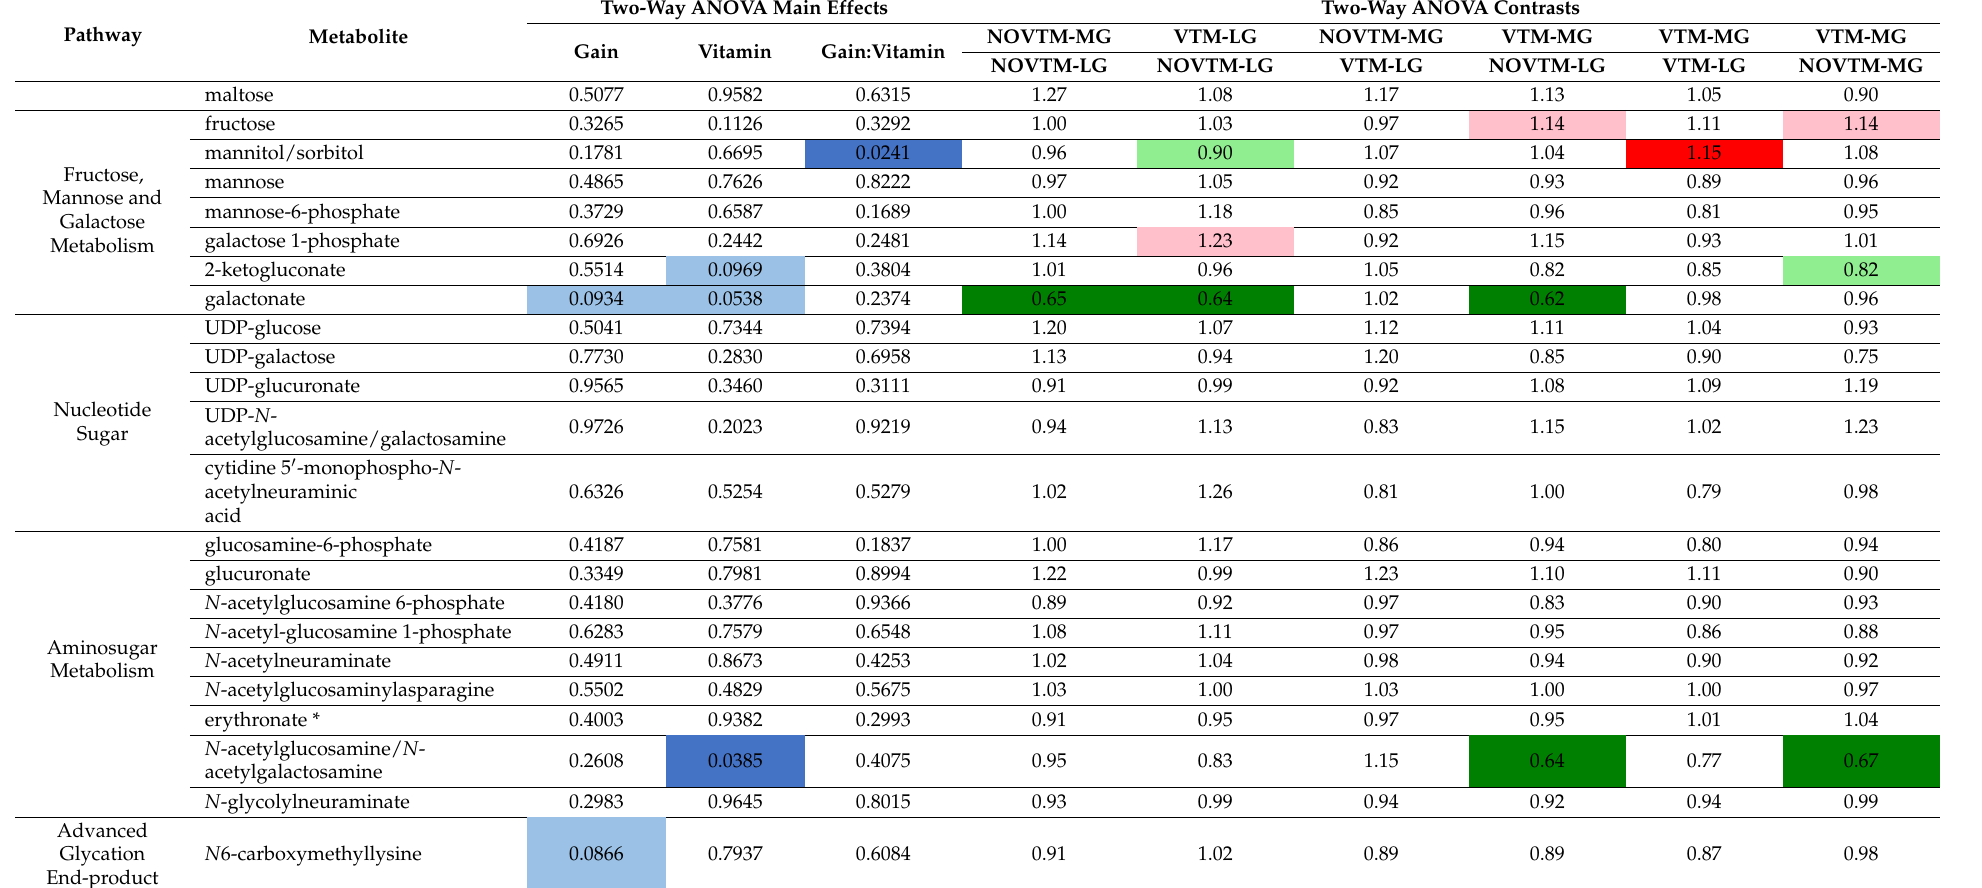
Red and green shaded cells indicate p ≤ 0.05 (red indicates that the mean values are significantly higher for that comparison; green values significantly lower). Light red and light green shaded cells indicate 0.05 < p < 0.10 (light red indicates that the mean values trend higher for that comparison; light green values trend lower). For the ANOVA, blue-shaded cells indicate p ≤ 0.05; light blue-shaded cells indicate 0.05 < p < 0.10. Metabolites denoted with * indicates a compound that has not been confirmed based on a standard but are confident in its